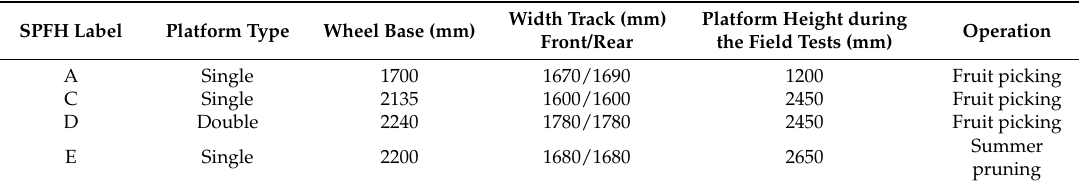
Table 1. Descriptive data of the tested SPFHs on operation in filed.